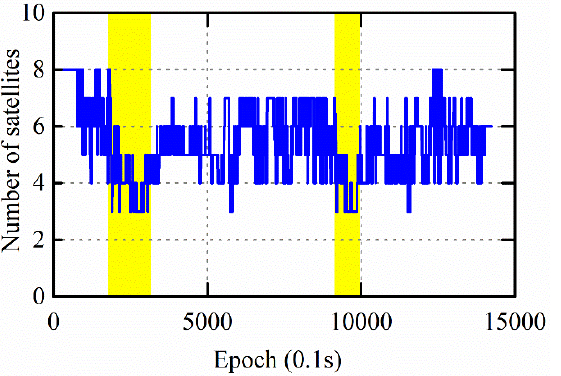
Figure 9. Number of visible GPS satellites.